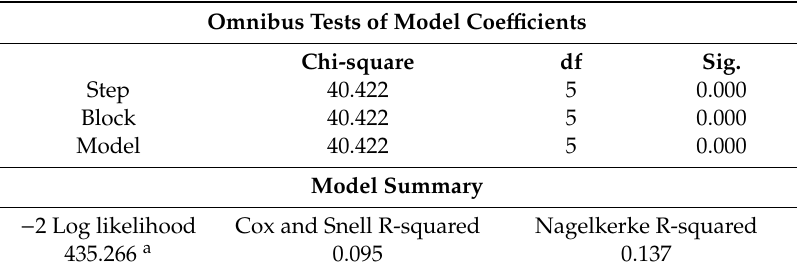
Table 4. Diagnostic tests of the binary logistic regression